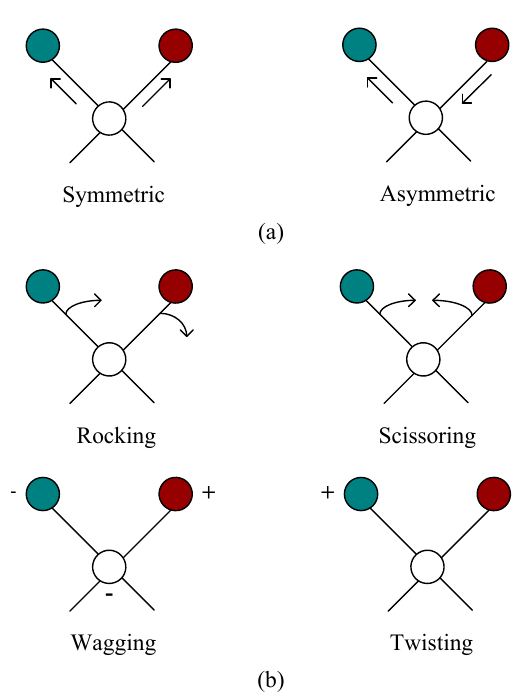
Figure 2. Molecular vibration form: ( a ) Stretching vibration and ( b ) bending vibration.